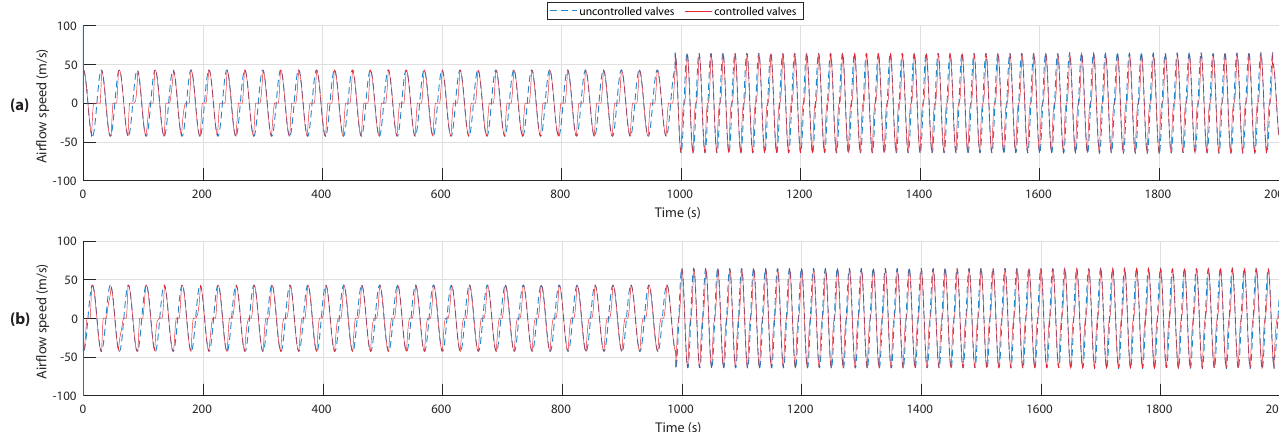
Figure 7. Obtained aiflow in the OWCs without and with airflow control. ( a ) Airflow in OWC1. ( b ) Airflow in OWC2. The resulting pressure from the obtained airflow speed of Figure 7 are presented in Figure 8 for both OWC1 and OWC2 without and with controlled